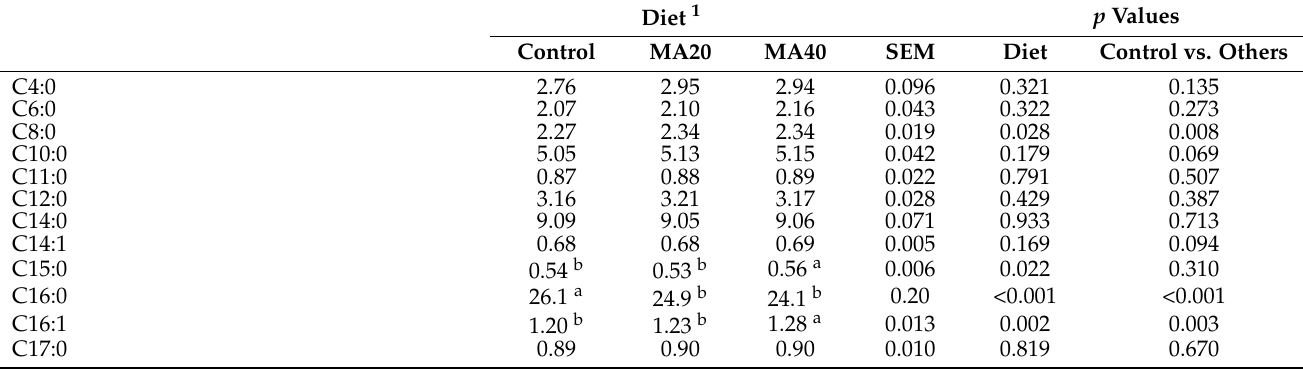
Table 6. Fatty acids profile (g/100 g total fatty acids) in milk of lactating Damascus goats fed diets containing Moringa oleifera and Chlorella vulgaris microalgae ( n =